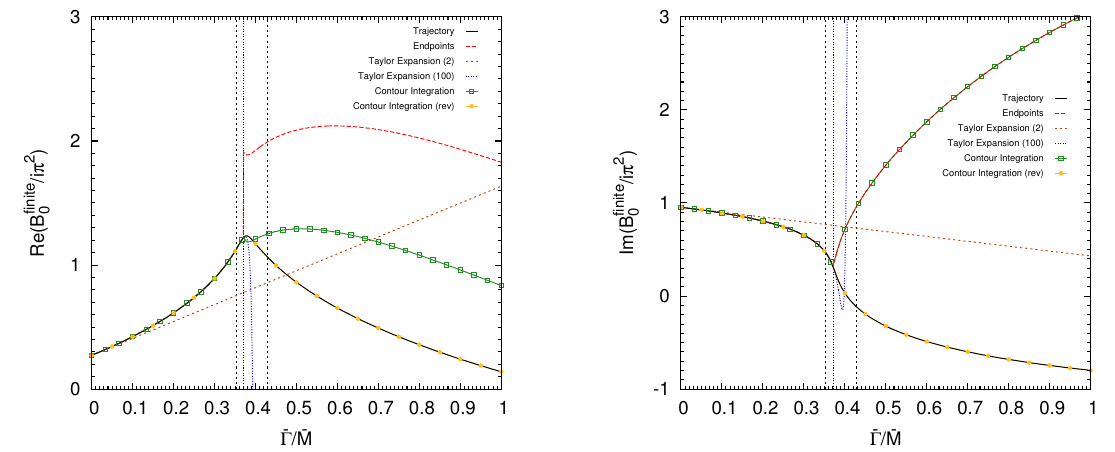
Figure 4. Results for the real (left panel) and imaginary (right panel) part of the UV-(cid:12)nite contribution to the r.h.s. eq. (5.35) (i.e. the non-divergent component of B 0 = ( i(cid:25) 2 )), as a function of (cid:22)(cid:0). The other widths and the masses are chosen according to con(cid:12)guration E in table 1. See the text for